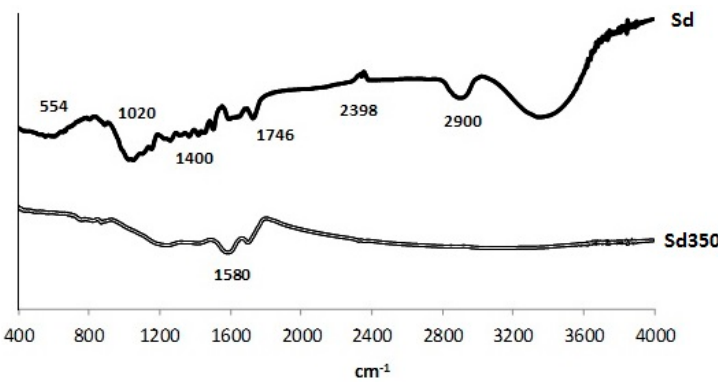
Figure 4. FTIR spectra of Sd and biochar Sd350.